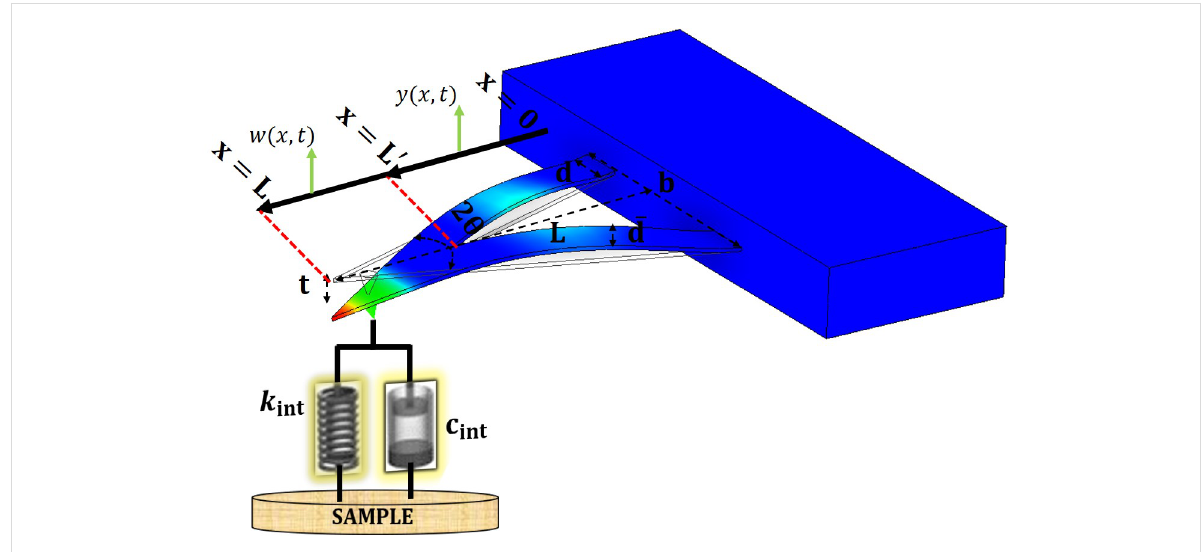
Figure 1: Schematic of V-shaped cantilevers with different geometrical